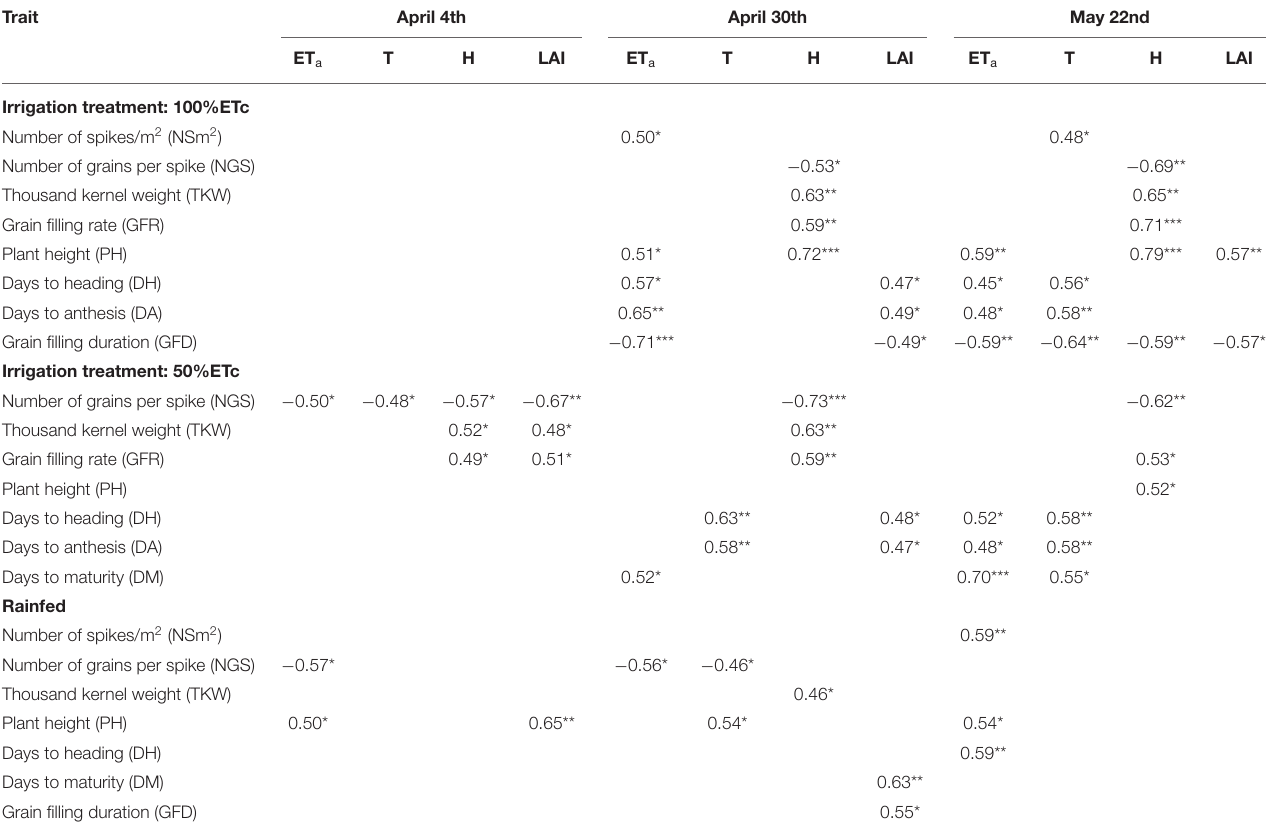
TABLE 5 | Significant ( P < 0.05) Pearson correlation coefficients (r) for the relationships between traits assessed through remote sensing and yield, yield-related traits and crop phenology for each irrigation treatment and each image acquisition event ( n =